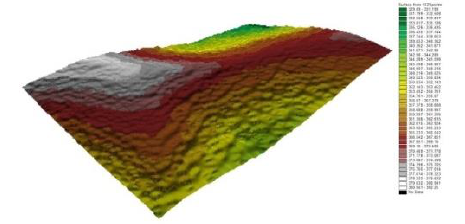
Table 1b. The statistical analysis results of the DEMs created from reduced point cloud LiDAR data.